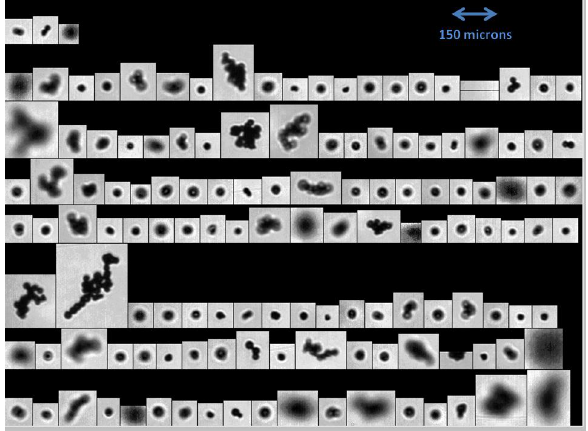
Fig. 6. CPI images of ice particles sampled between 22:20:00 and 22:20:02.